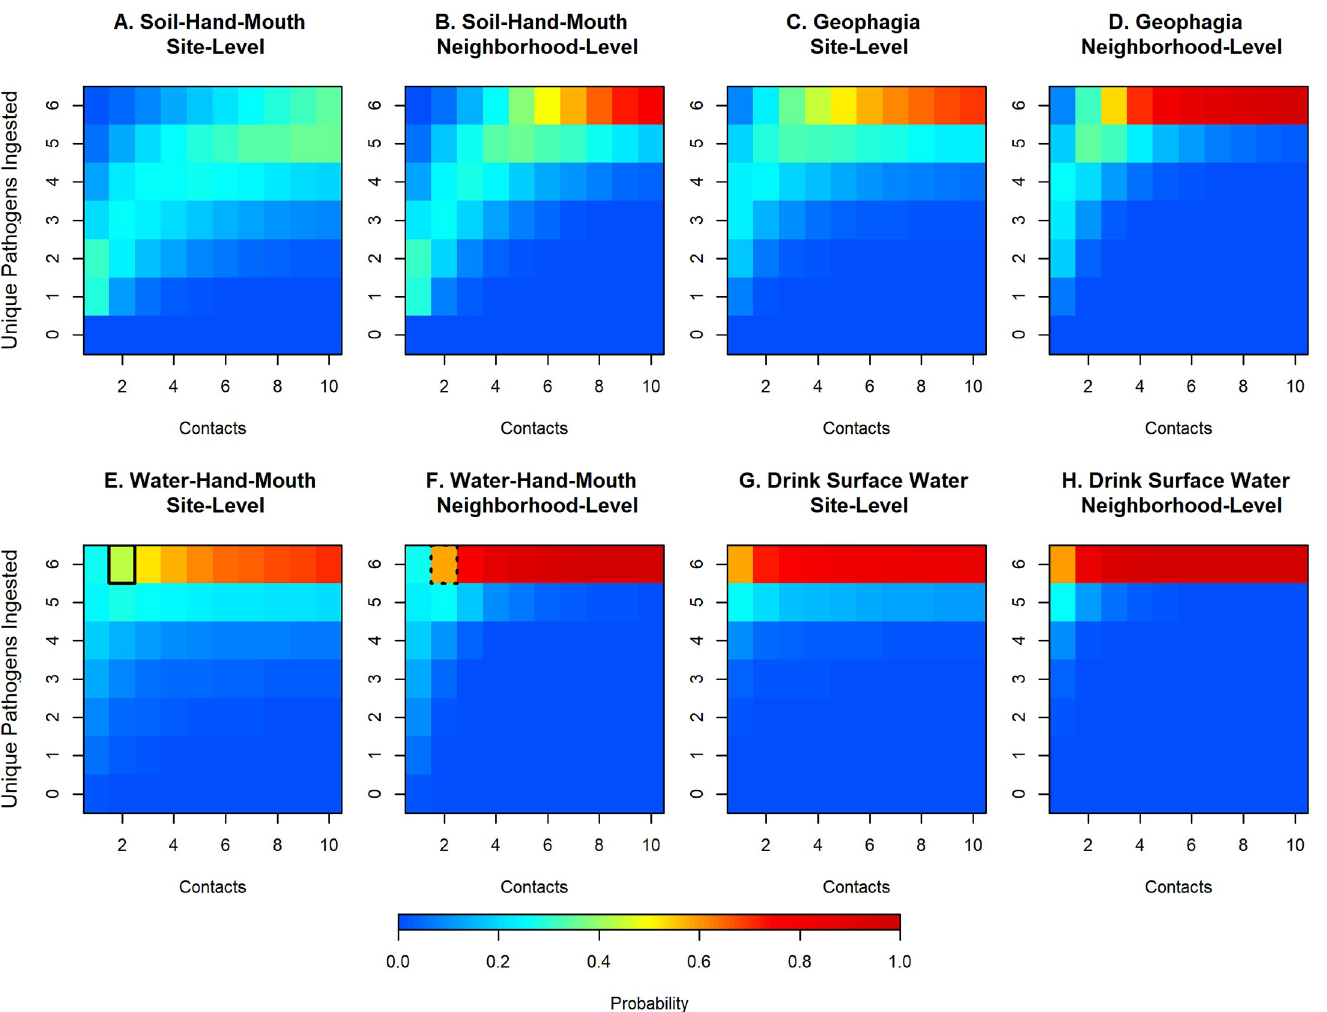
Fig 4. Probability of ingesting one or more enteric pathogens with increased frequency of exposure contact with soil or surface water at site-restricted and neighborhood levels of scale. Multi-pathogen exposure is shown for (A) soil-hand-mouth exposure behaviors at a single residential public site; (B) soil-hand-mouth exposure behaviors at two or more residential public sites within a neighborhood; (C) geophagy behaviors at a single residential public site. (D) geophagy behaviors at two or more residential public sites within a neighborhood; (E) water-hand-mouth exposure behaviors at a single residential public site; (F) water-hand-mouth exposure behaviors at two or more residential public sites within a neighborhood; (G) drinking surface water at a single residential public site; (H) drinking surface water at two or more residential public sites within a